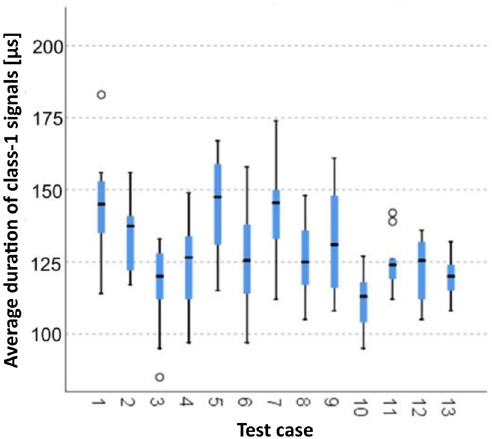
Figure 4. Graphic presentation of the Kruskal–Wallis test results for independent samples: average duration of class-1 signals.